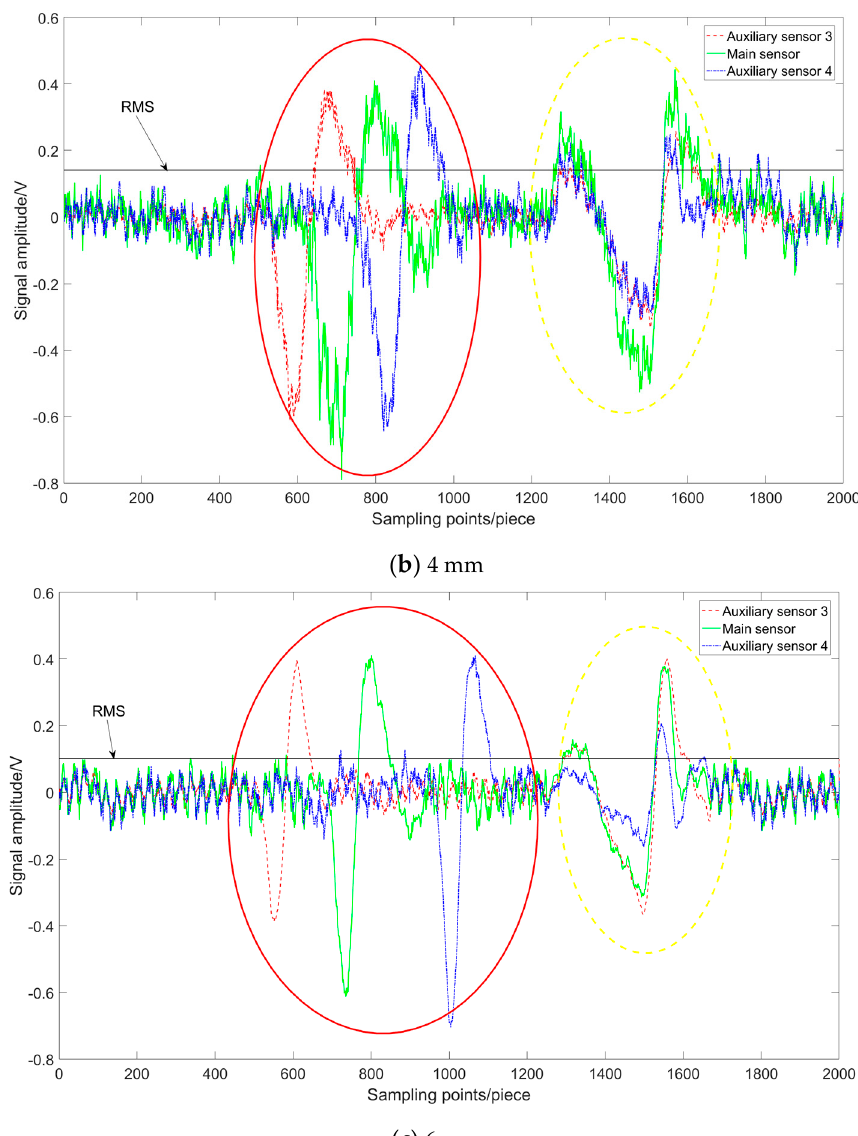
Figure 12. z -component results with different distance.